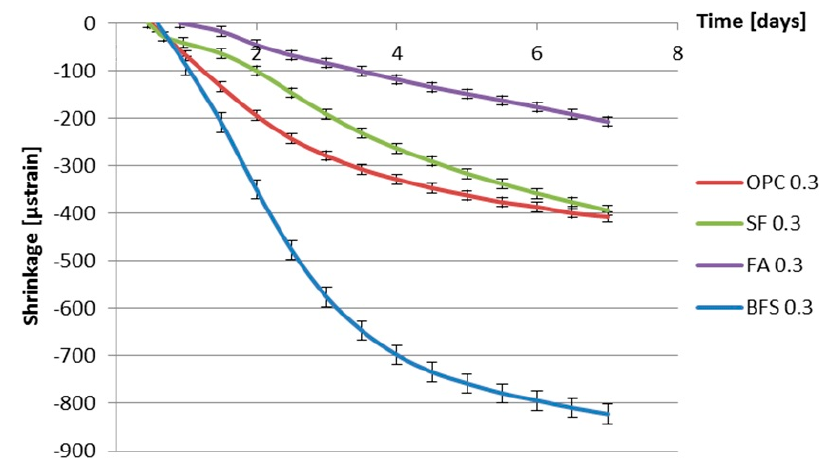
Figure 14. Autogenous deformation vs. age for different kinds of cement paste with water–binder ratio of 0.3 (starting time: after early-age swelling).